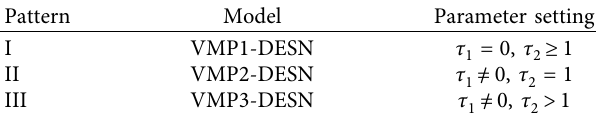
Table 1: Different pattern cases of VMP-DESN. Pattern Model Parameter